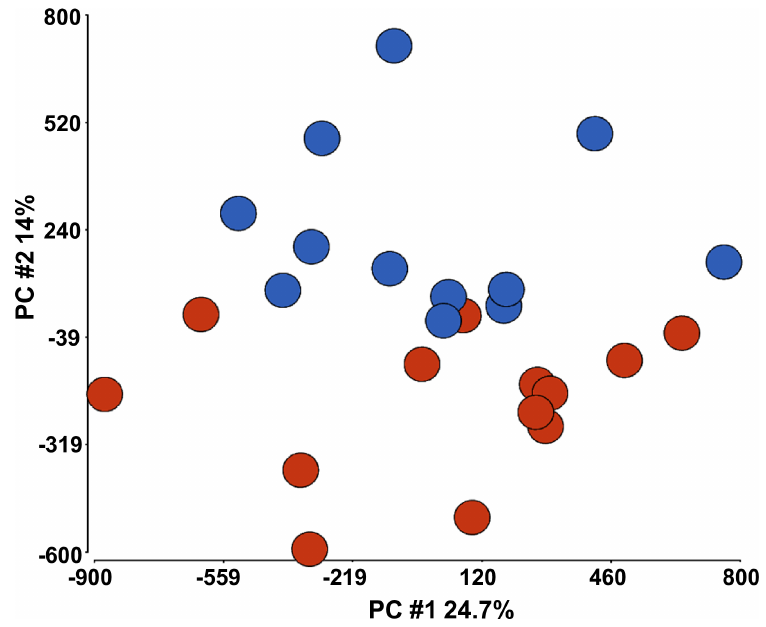
Fig 2. Principal component analysis of whole DNA methylomes allows differentiating between ME/CFS cases (N = 13, red circles) and matched controls (N = 12, blue circles).